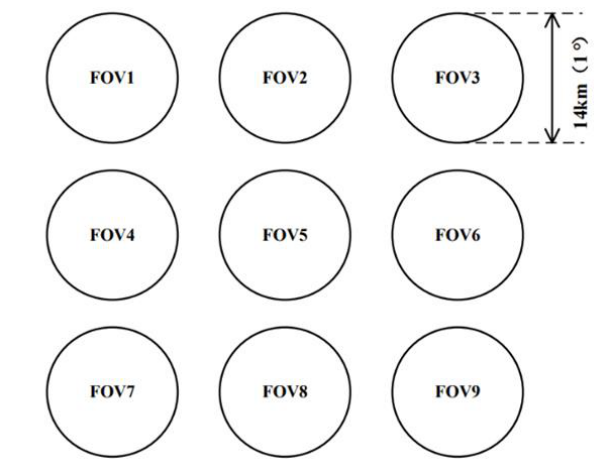
Figure 10. Illustration of the arrangement of the ground field of view for each detector (3 × 3 FOVs).